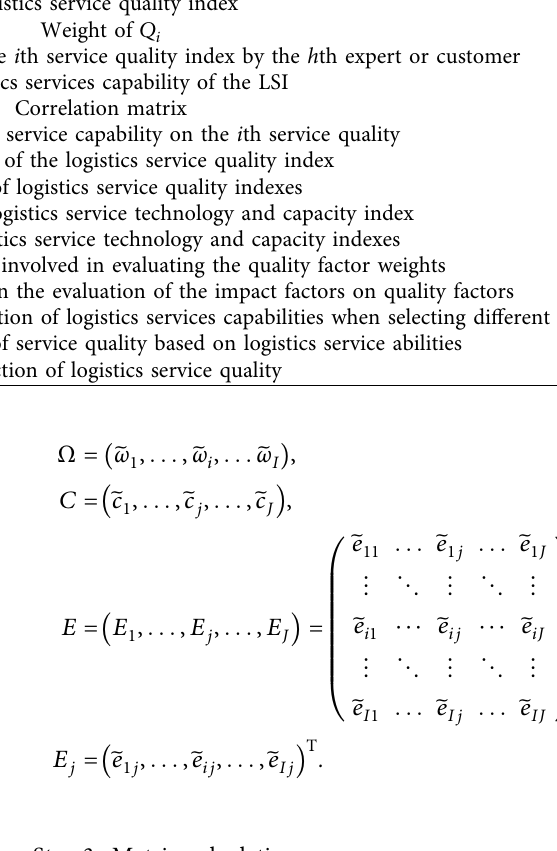
Figure 3: House of